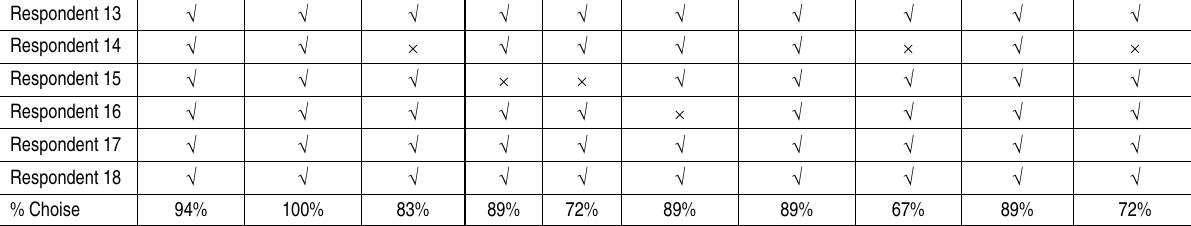
Table 3 (cont). Choice of content areas to assist respondents in the achievement of project goals